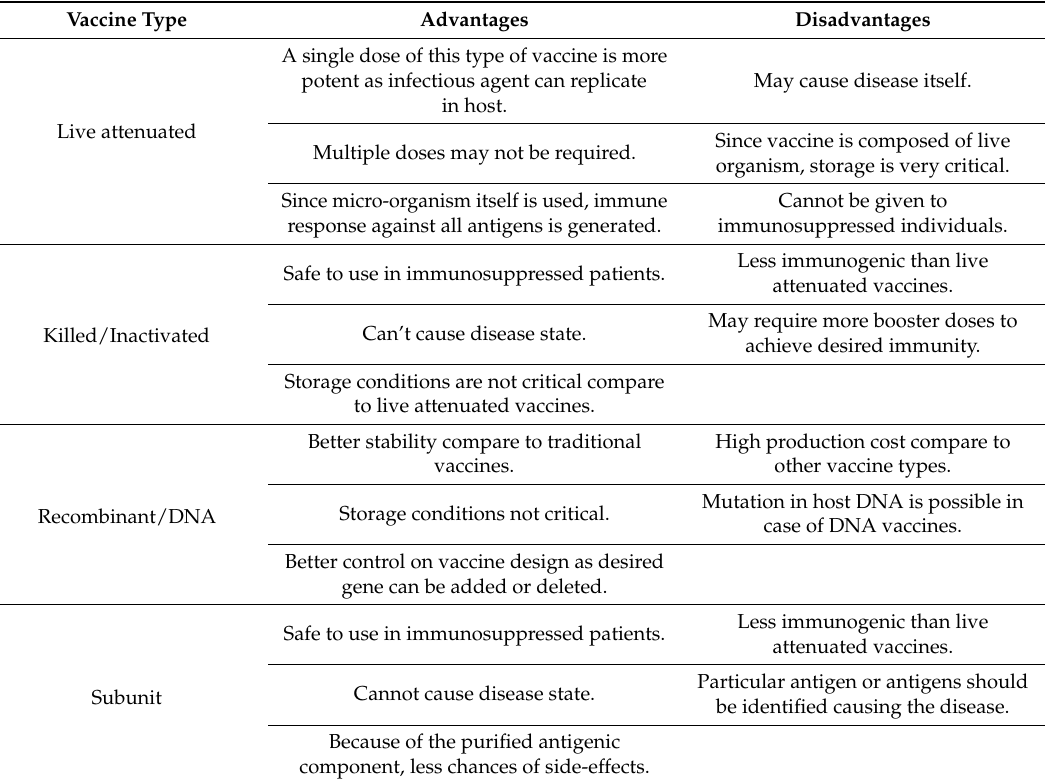
Table 1. Advantages and disadvantages of different vaccine